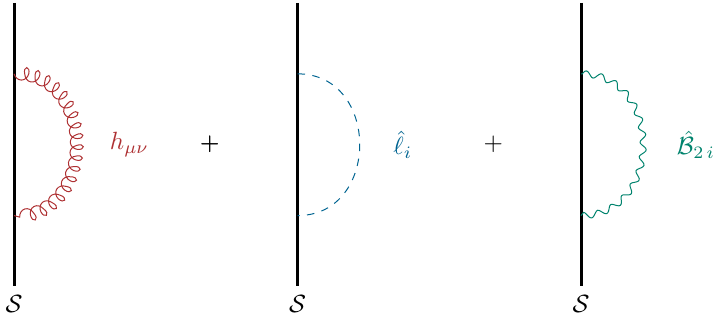
Figure 6 . The self interactions of a string due to the graviton g µν , dual saxion ‘ and gauge two- form B 2